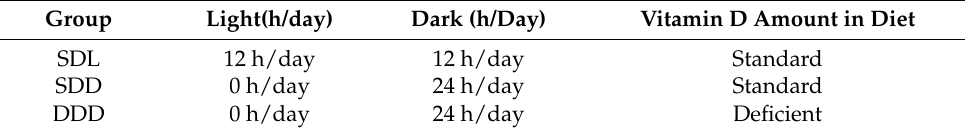
Table 2. Vitamin D diet and UV light conditions for the three mice groups.